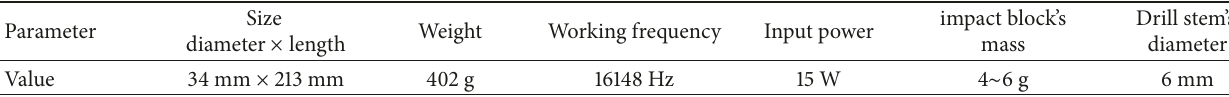
Table 4: Parameters of the ultrasonic drill prototype.